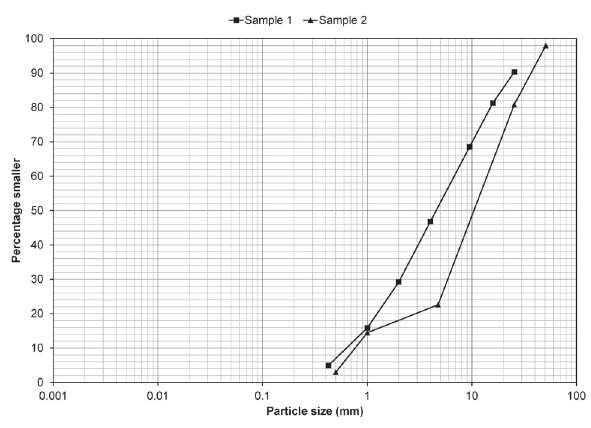
Figure 1: Particle size distribution of two coal samples.